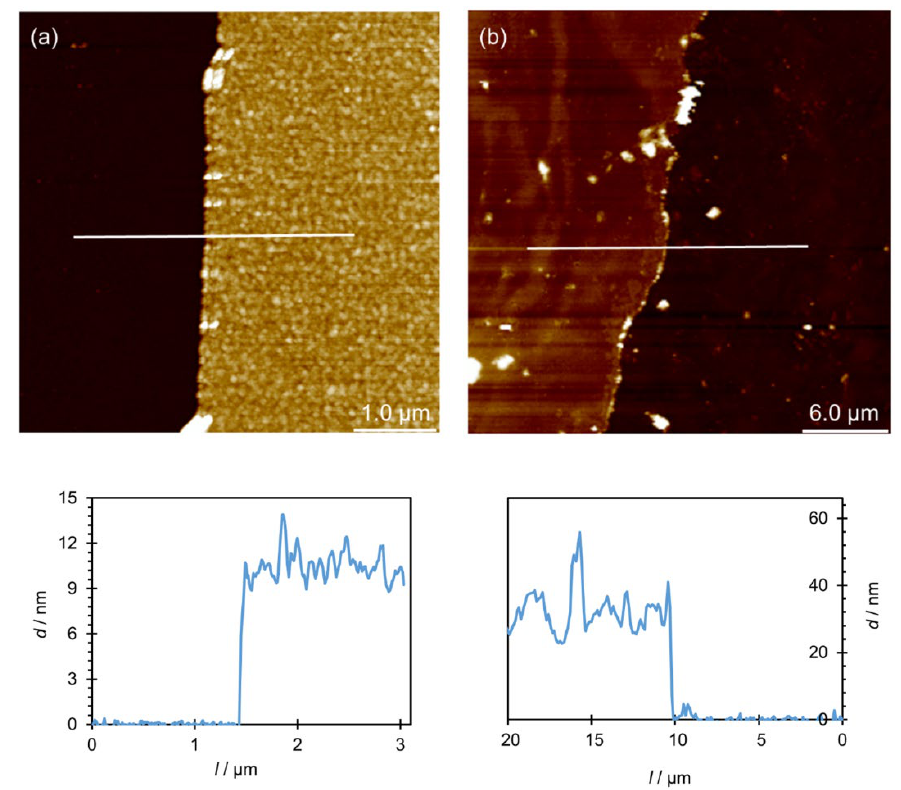
Figure 6. AFM images of step-edge boundary between (PAH/PAA) 5 multilayer and ( a ) silicon or ( b ) titanium surface. The corresponding height profiles are shown below the images. Table 3. Thickness of PAH/PAA multilayers on silicon and titanium substrates determined by el- lipsometry and atomic force microscopy.